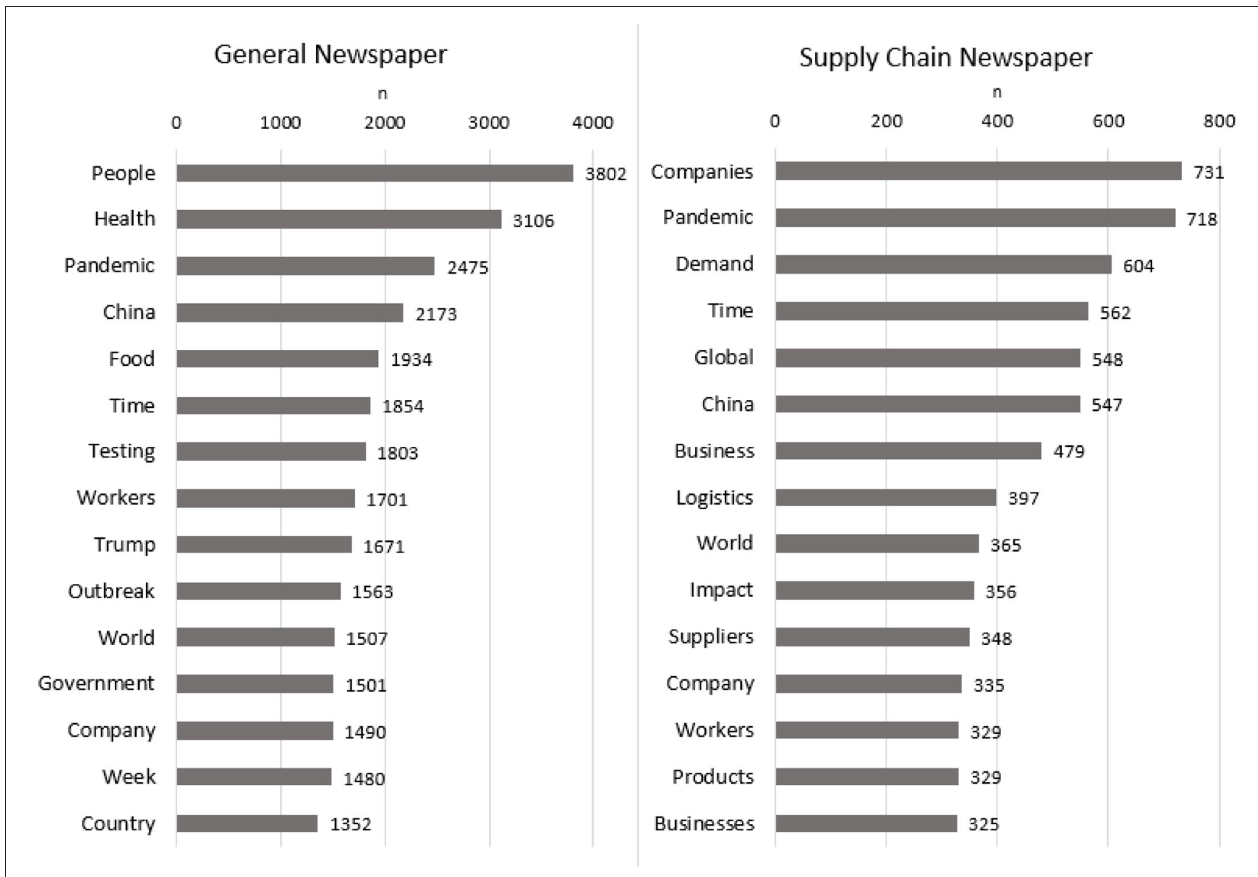
FIGURE 1 | Frequency plots ( n = amount of words